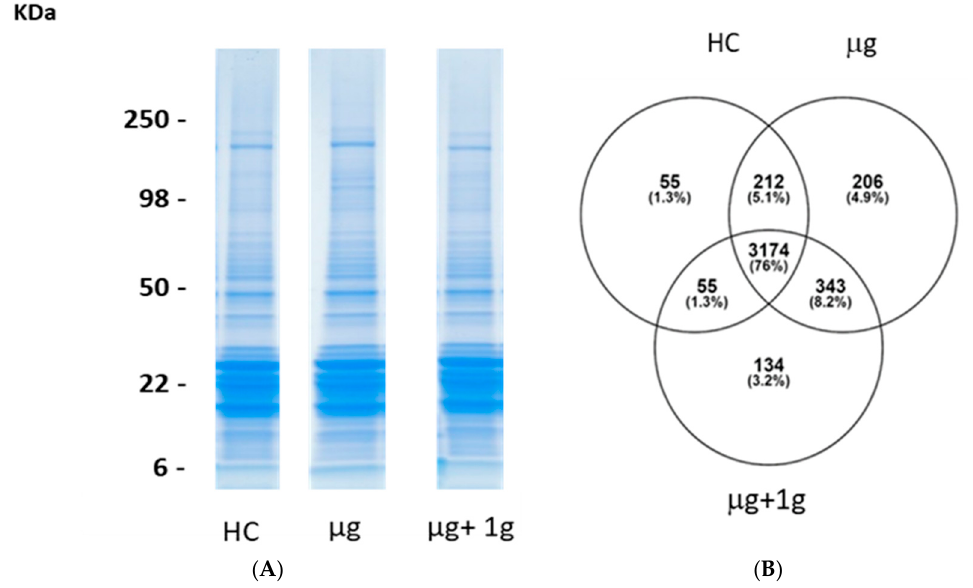
Figure 2. Proteins identified from µg, µg + 1 g , and habitat controls (HC) by high-resolution mass spectrometry. ( A ) Five micrograms of protein was resolved by one-dimensional sodium dodecyl sulfate–polyacrylamide gel electrophoresis (SDS-PAGE) and visualized by Coomassie-staining. Eyecups contain retinal layers were used for proteomic analysis. Samples were analyzed with six biological replicates. Each gel lane was sliced into 24 equivalent sections. Protein in each gel slice was digested in-gel with trypsin and identified by high-resolution mass spectrometry; ( B ) a Venn diagram represents the number of total proteins identified from each group. Seventy-six percent of the proteins were identified in all three